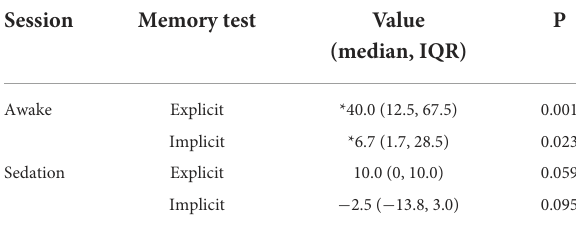
TABLE 2 Explicit and implicit memory scores before and after dexmedetomidine